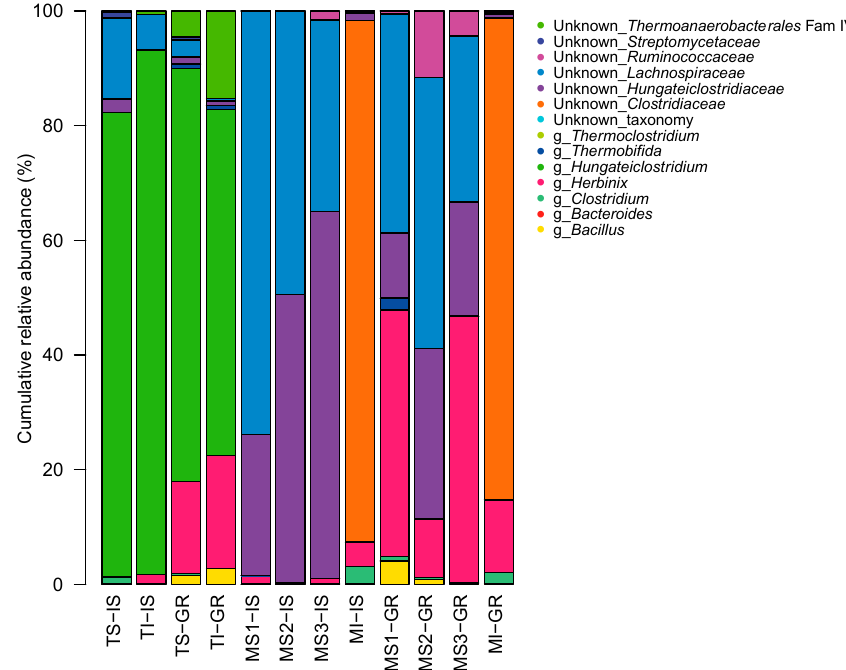
Figure 3. Taxonomic binning of GH48 gene sequences amplified in DNA of lab-scale biogas fermenters at genus level. TS—thermophilic stable; TI—thermophilic instable; MS—mesophilic stable; MI—mesophilic instable; IS— in sacco ; GR—raw digestate.